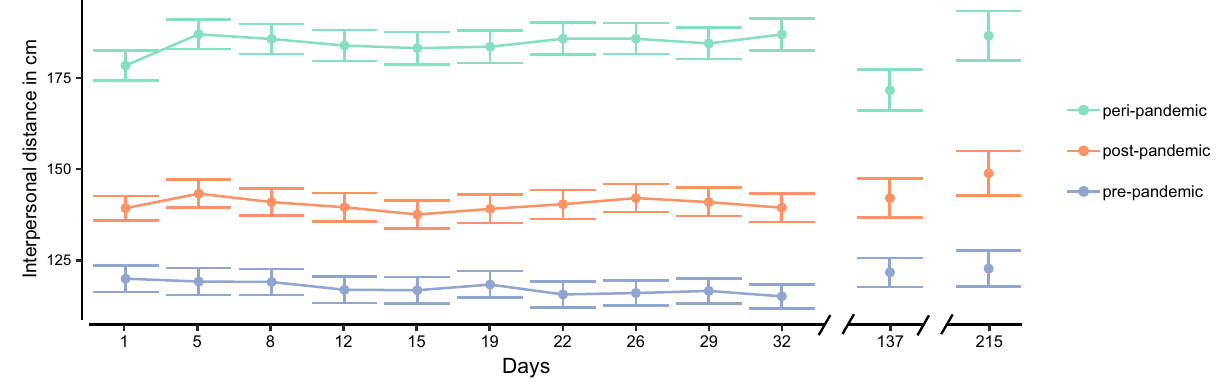
Figure 2. Interpersonal distance in cm as a function of days since the first measurement (one week after the beginning of the first lockdown in Germany) and IPD measure (peri-, post-, pre-pandemic). The IPD measures were averaged across the silhouette marks our last measurement within the first wave of infections. Descriptively, peri-pandemic IPD dropped on day 137, see Figs. 2 and 3, but was reinstated on day 215. We can also see a substantial increase in post-pandemic IPD on day 215, accompanied by a small rise in pre-pandemic IPD. To establish whether these trends can be substantiated, we separately tested the individual IPD differences between day 32 and day 137 as well as between day 32 and day 215 ( N = 66 for day 137 and N = 52 at day 215) against 0 (effect coding with −0.5, + 0.5). Again, we added subject-specific intercepts and varying slopes for the silhouettes to the model. Additionally, we fitted the residuals to a studentized distribution to control for potential outliers in this subset of our data and allow for better shrinkage, resembling a Bayesian t -test. Compared to day 32, we found a decrease in peri-pandemic IPD on day 137, but not on day 215. This increase in IPD contradicts the previous trend in the data. Also, in contrast to the previous trend, we found a retrospective distortion of reporting relatively larger pre-pandemic IPD, which was statistically distinguishable for day 137, see Table 1. For post-pandemic IPD, the effect was distinguishable on day 215 (see Table 1), where post-pandemic IPD was around 6 cm larger than on day 32. That is, at the end of our study and at the wake of the second wave, subjects predicted post-pandemic IPD to nearly coincide with the minimum physical distance (150 cm) requirement